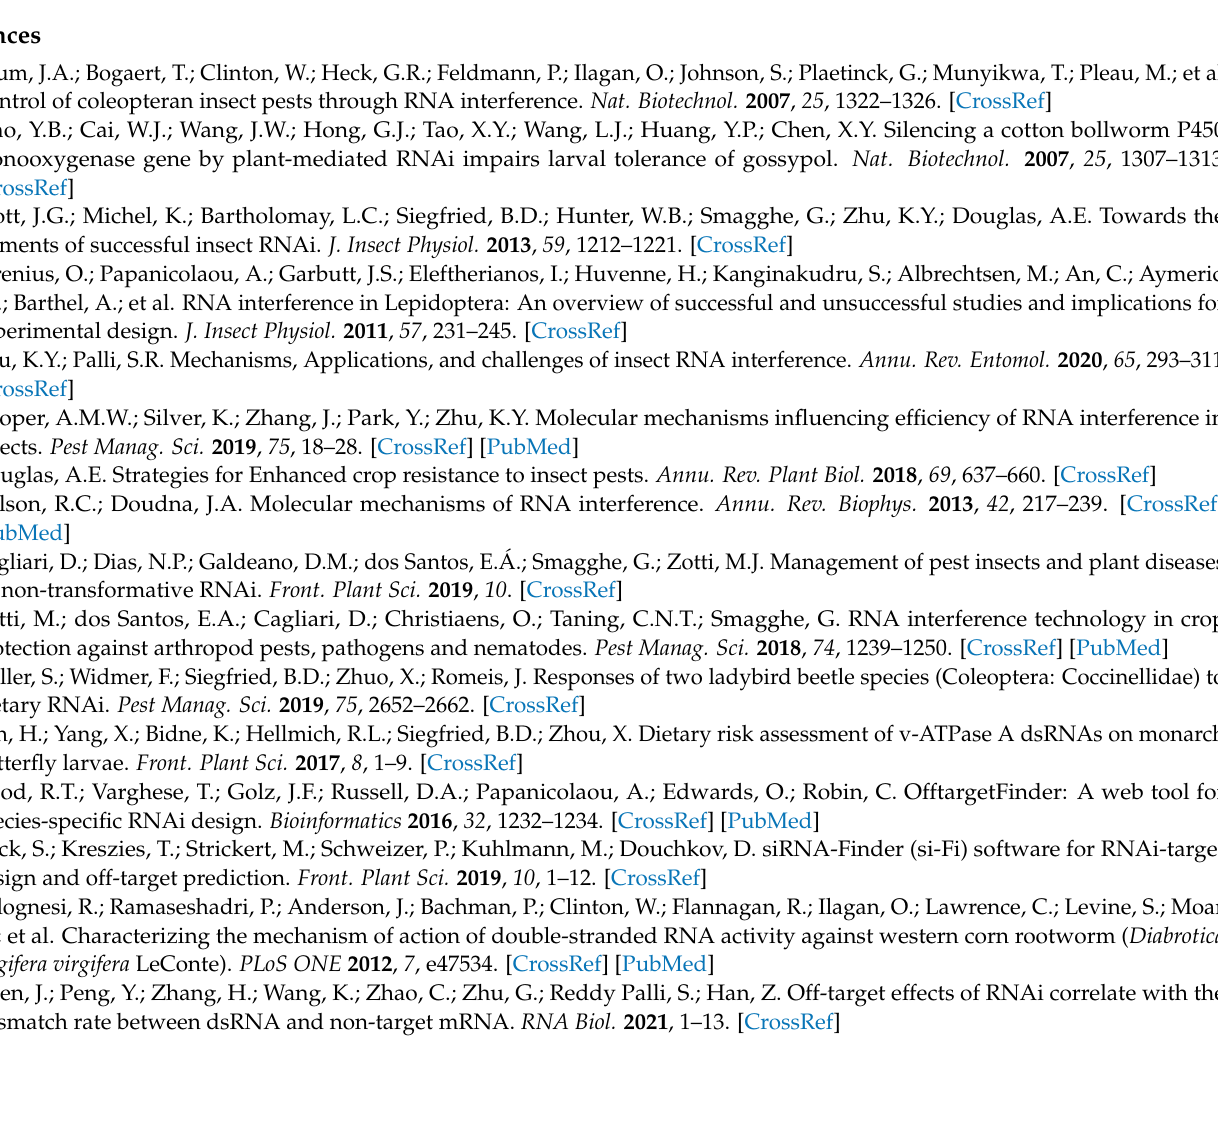
represents the A. pisum ds NUC sequence. Figure S5. Alignment of M. persicae NUC and P. maritimus NUC . Red font represents the M. persicae ds NUC sequence. Figure S6. Alignment of M. persicae NUC and B. tabaci NUC 1. Red font represents the M. persicae ds NUC sequence. Figure S7. Alignment of M. persicae NUC and B. tabaci NUC 2. Red font represents the M. persicae ds NUC sequence. Figure S8. Alignment of B. tabaci NUC 1 and B. tabaci NUC 2. Red and green represent B. tabaci ds NUC 1 and ds NUC 2